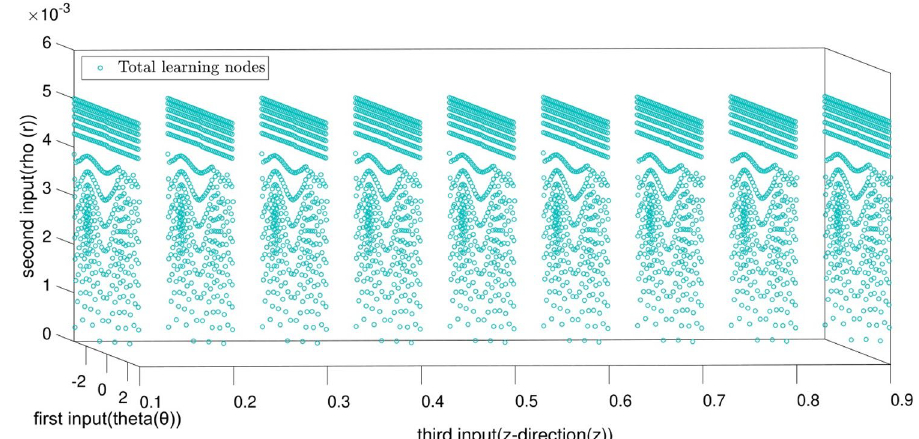
Figure 2. Learning data which is CFD output.